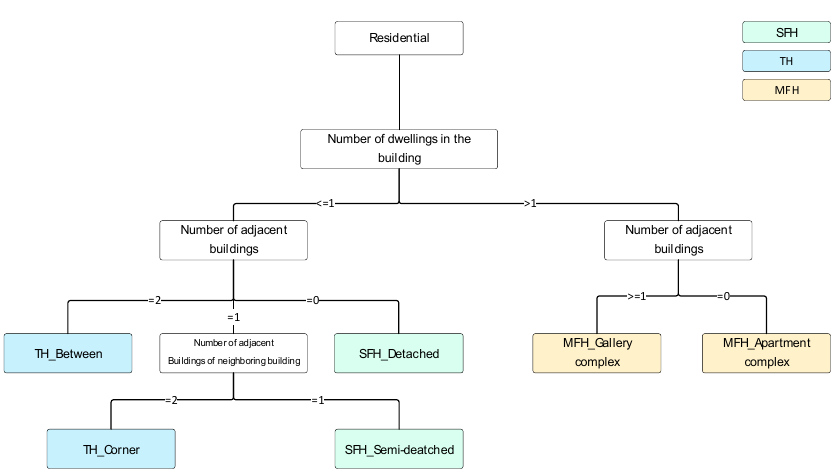
Figure 3. Dwelling typology classification based on topology relation and number of addresses per building unit. Retrieved from Wang [21].